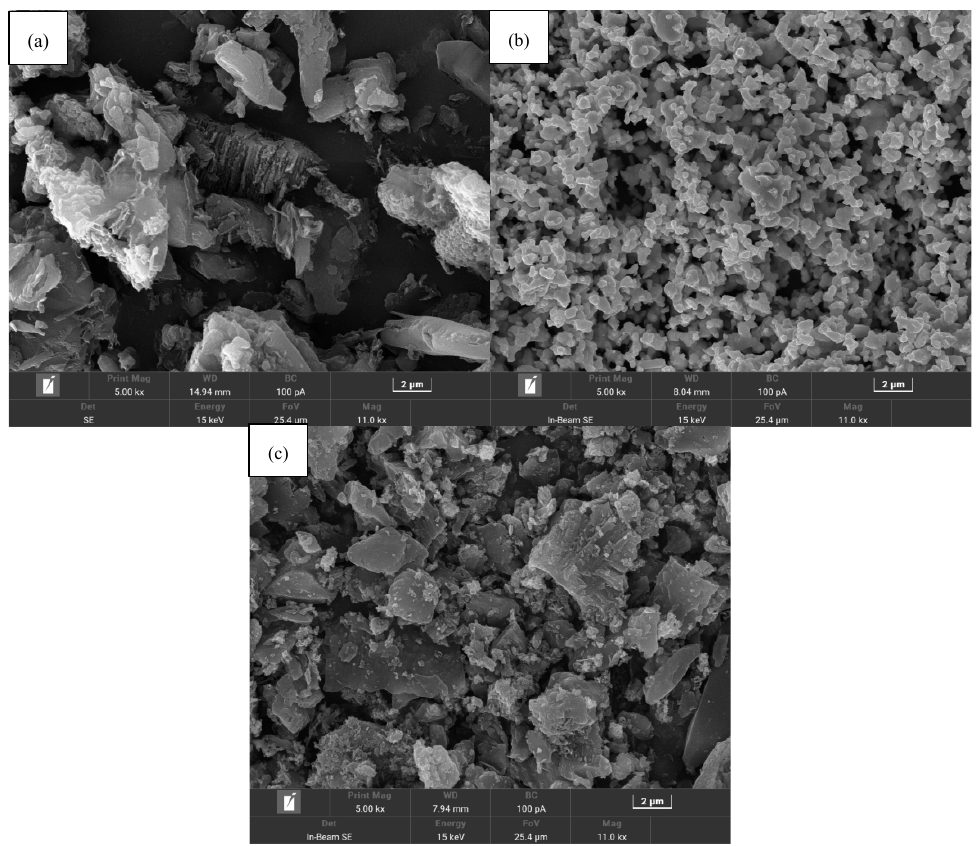
Figure 1. SEM images of g ‐ C 3 N 4 ( a ), Ag 2 O ( b ), and Ag 2 O/g ‐ C 3 N 4 ( c ).